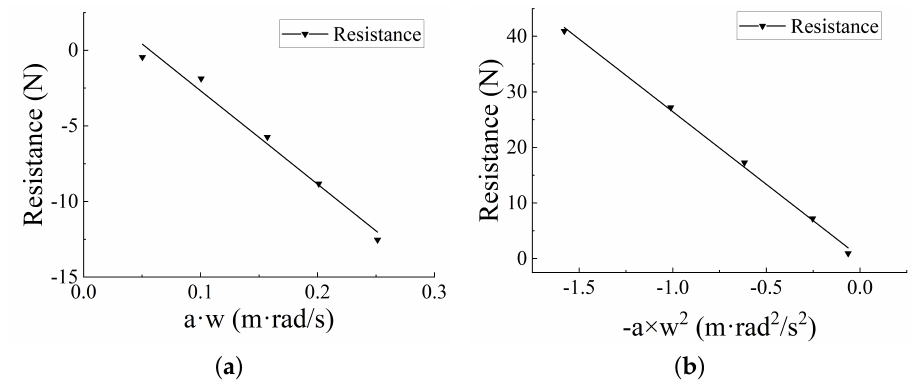
Figure 15. Change of heaving resistance Z with respect to motion parameters a and ω in the PMM test simulation. ( a ) Change of resistance Z with respect to a · w ; and ( b ) change of resistance Z with respect to − a · w 2